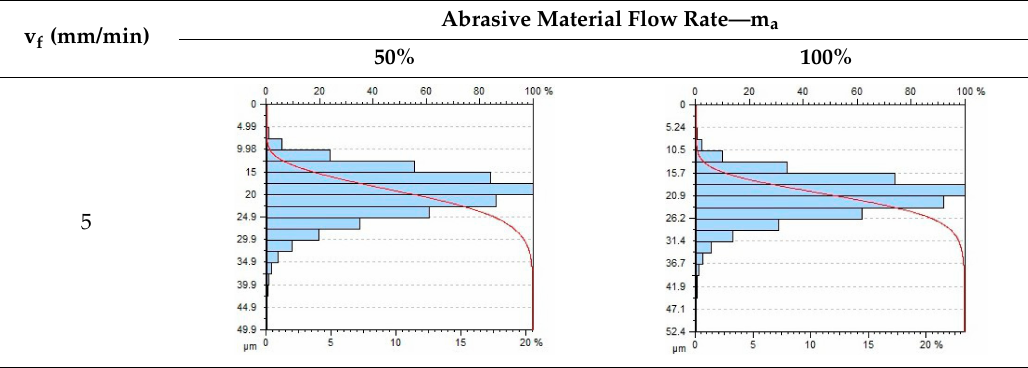
Table 4. Abbott-Firestone curve describing abrasive material flow